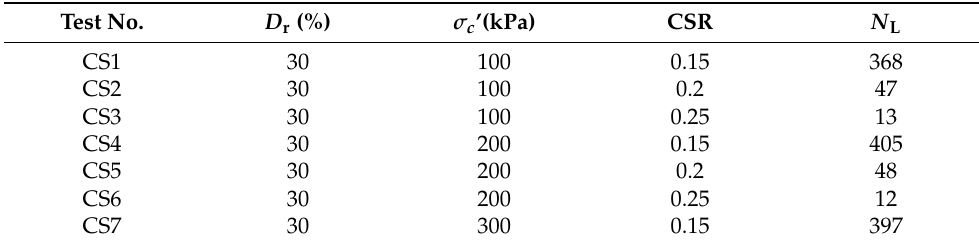
Table 2. Test conditions and